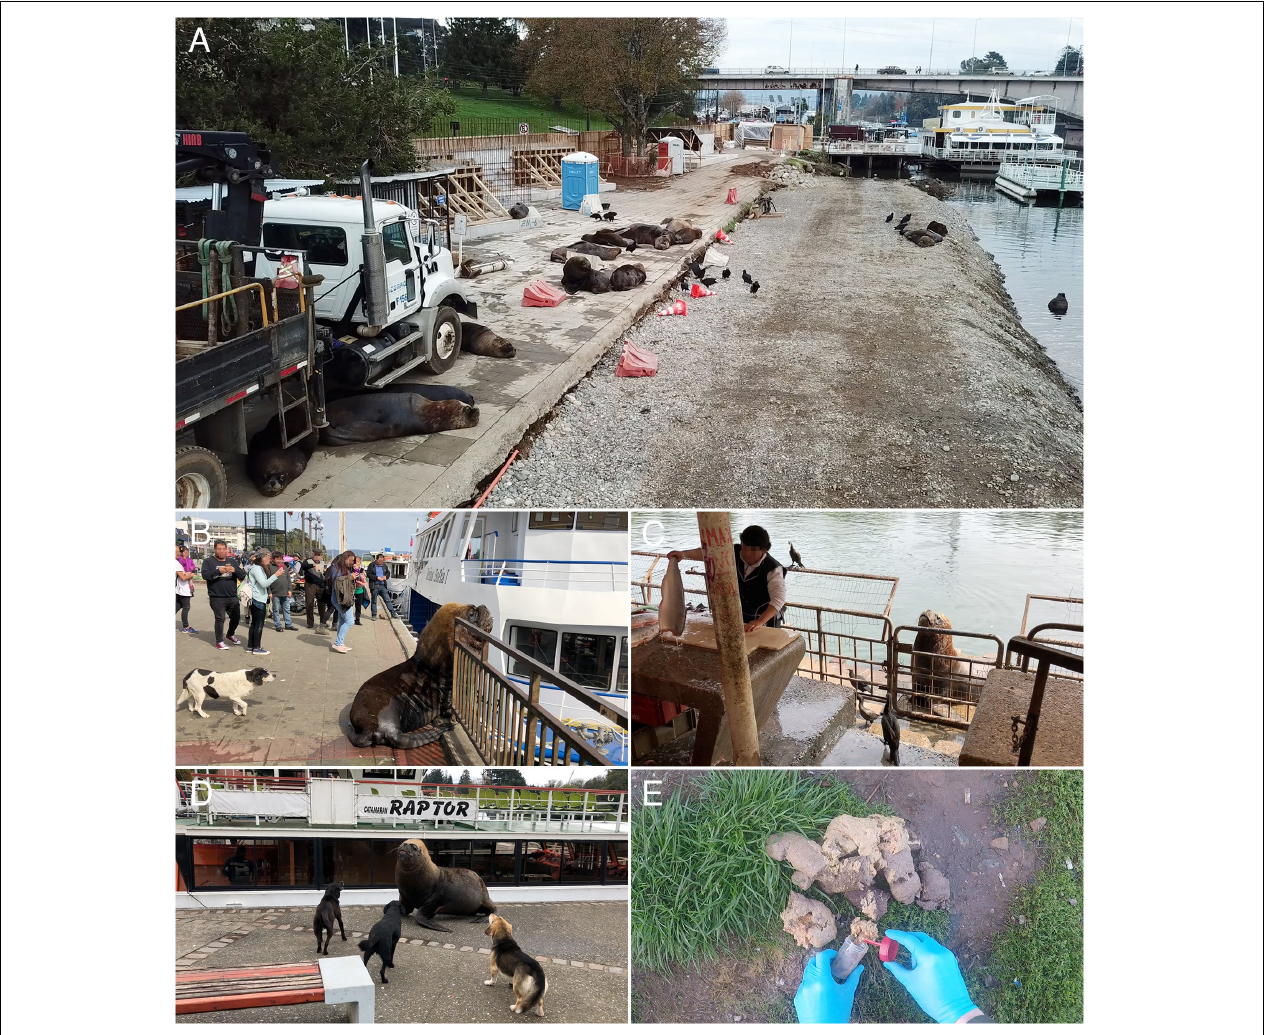
FIGURE 2 | “Urban” colony of South American sea lions living in the city of Valdivia, Chile. (A) Individuals resting at a construction site located at river Calle-Calle in immediate proximity to construction material, a truck and a portable toilette. (B) Dominant Otaria flavescens male resting at main square in front of humans and a stray dog. (C) Sea lion waiting for fish remains infront of the local fish market of Valdivia surrounded by cormorants and black vultures. (D) Three stray dogs attacking a sea lion individual at the pier. (E) Sampling of sea lion feces within the city of